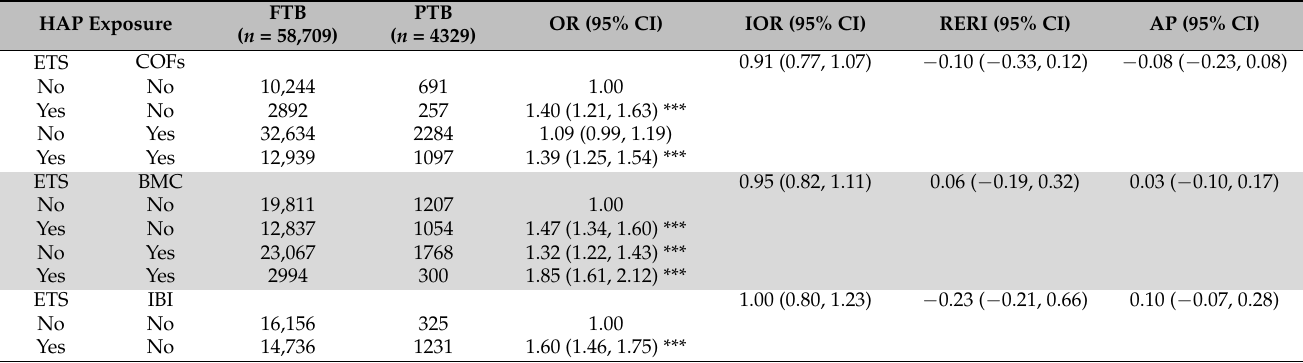
Table 4. Interaction effects of prenatal exposure to five sources of HAP on